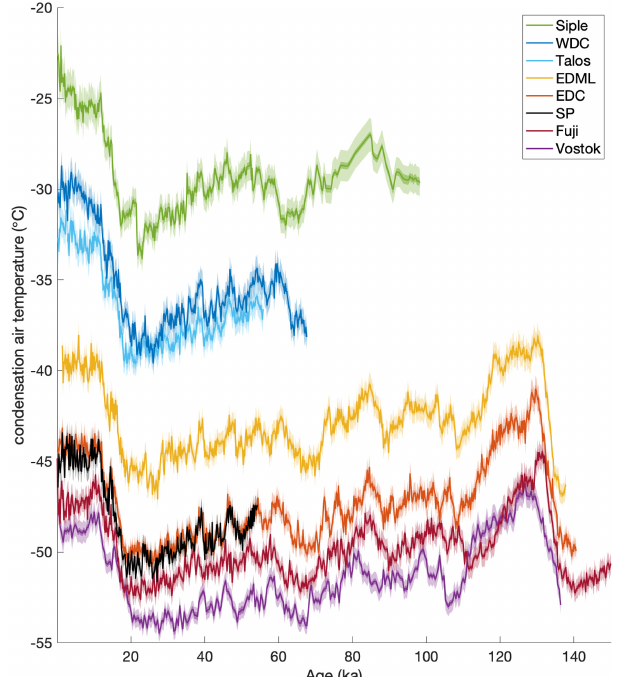
Figure A19. Surface air temperature reconstruction for all ice-core sites. The light shading around the reconstructions represents the uncertainty in absolute temperature, while the darker shading repre- sents the uncertainty in relative temperature variability as described in Sect.